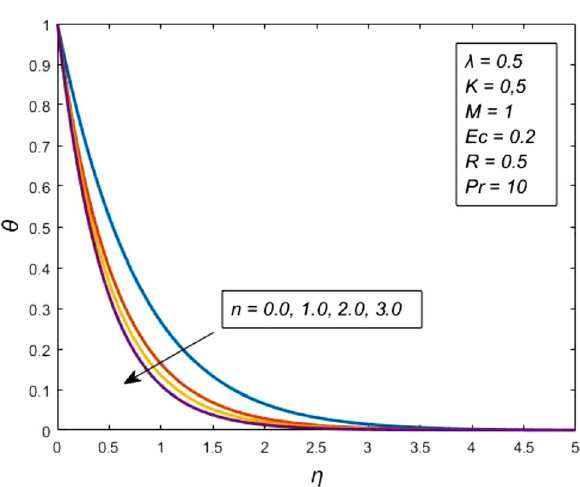
Figure 5. Impact of nonlinear stretching sheet parameter n on the temperature